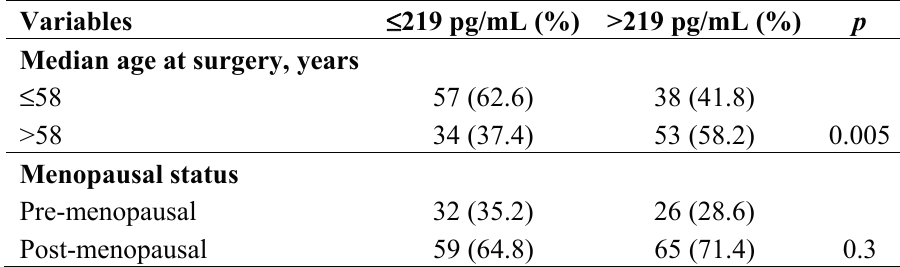
Table 2. Correlation of preoperative serum PN median level with clinical pathological features and tissue PN